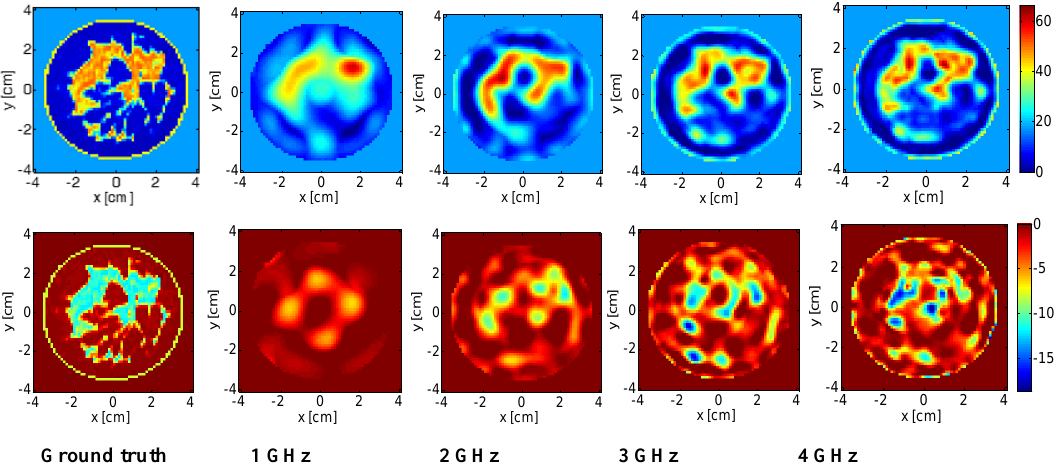
Figure 2. Dense breast (ID 062204). Real part ε′ ( top ) and imaginary part ε″ ( bottom ) of the reference permittivity and of the reconstructed profile at (from the left to the right) 1 GHz, 2 GHz, 3 GHz, and 4 GHz.